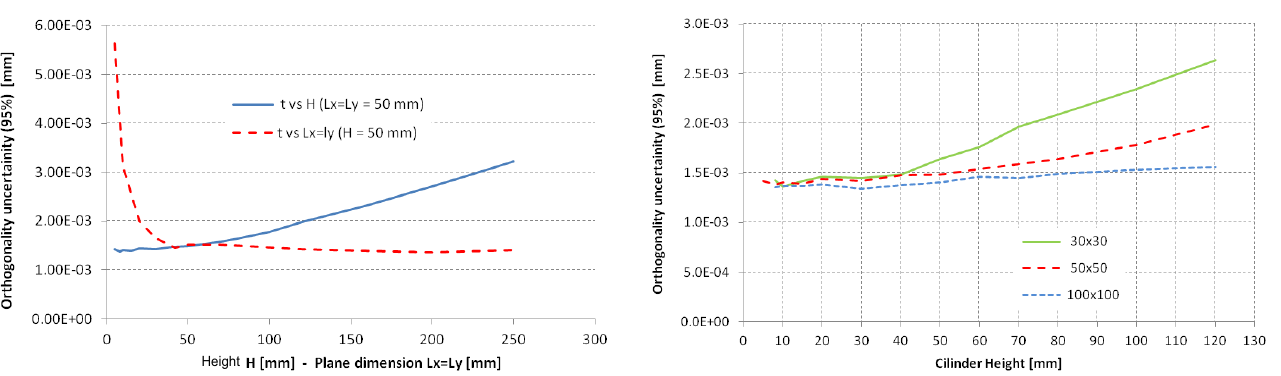
Fig. 8. Versor angle α uncertainty.